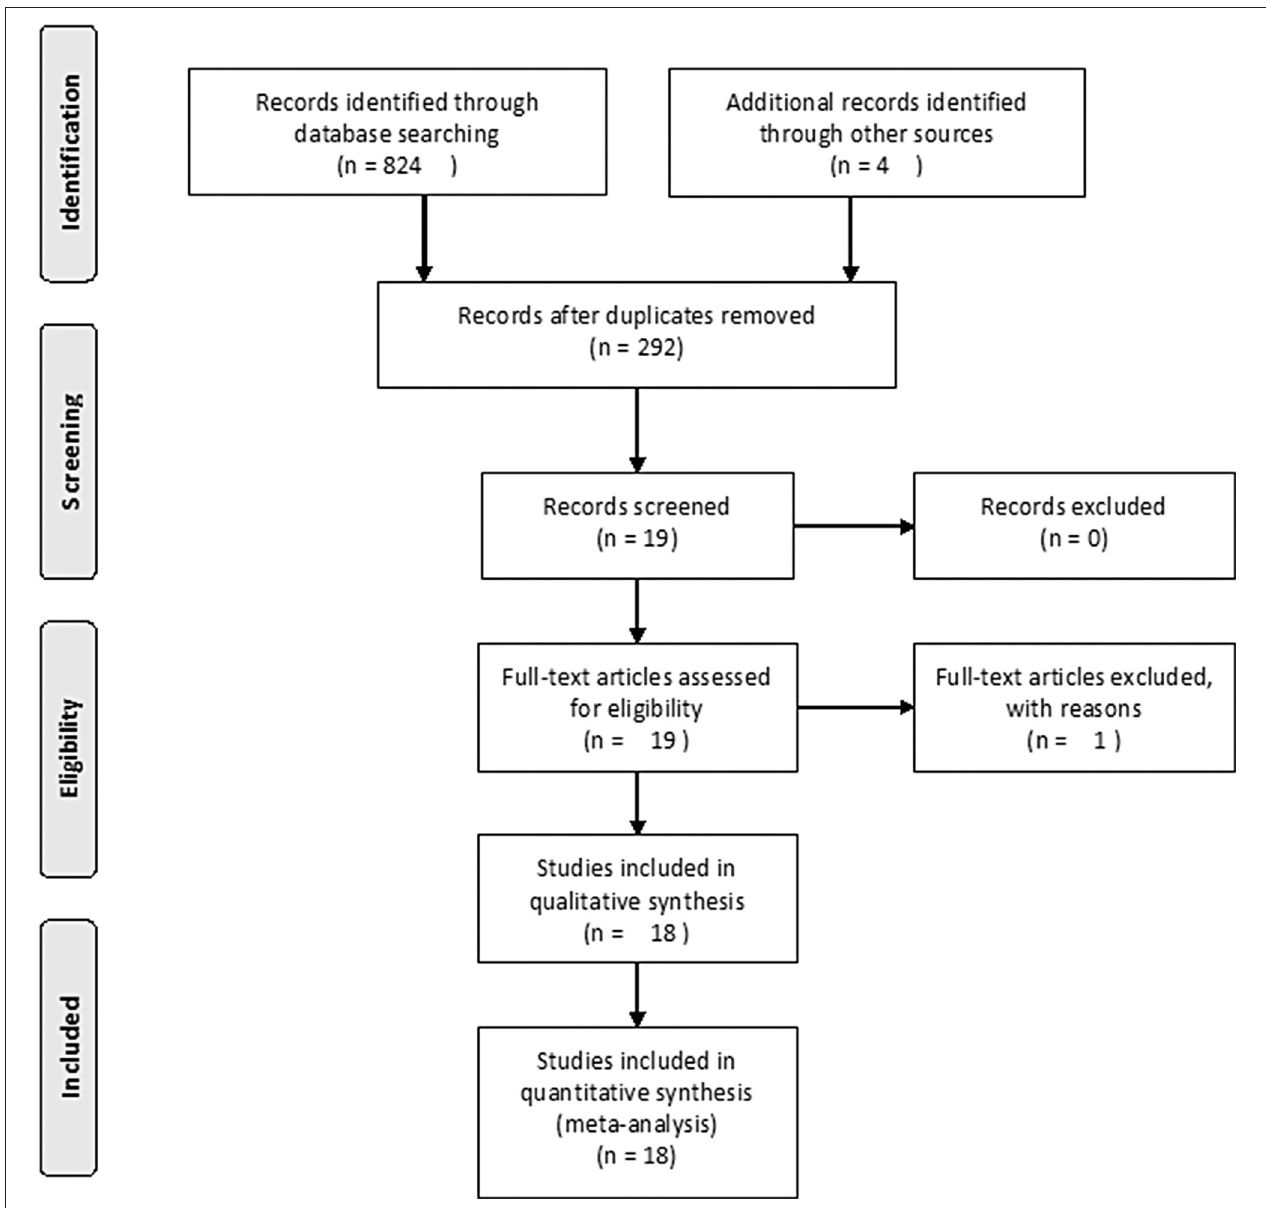
FIGURE 1 | PRISMA flow